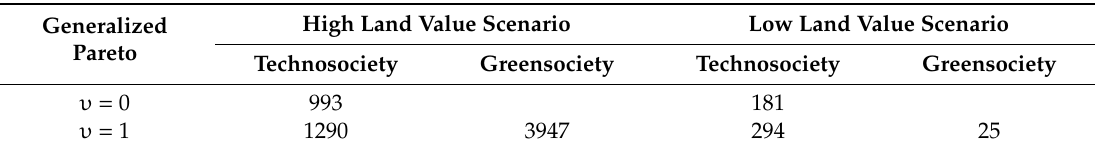
stochastic case.